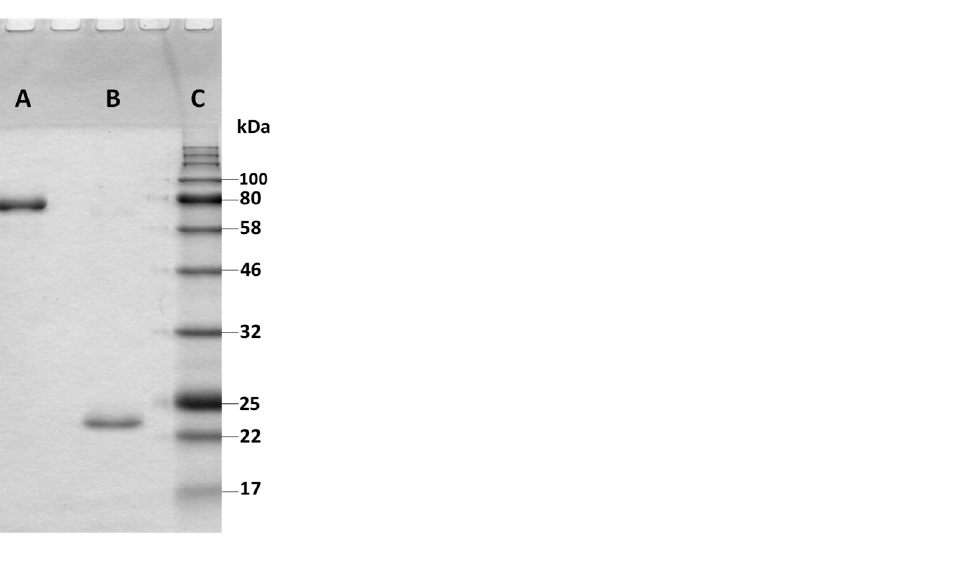
Figure 1. SDS-PAGE of the purified B. spectabilis ATHUM 8891 hemicellulases. ( A ) PvXyd3A, ( B ) PvXyn11A, ( C ) Protein marker NEB (#P7712).